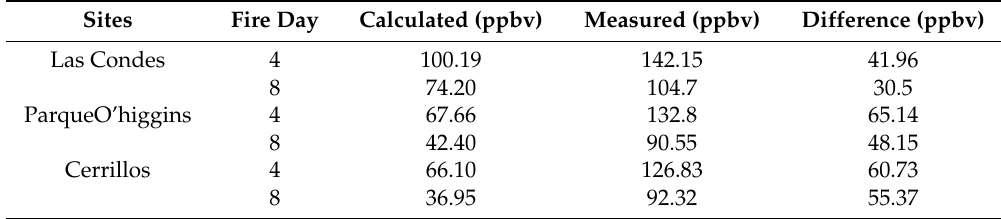
Table 2. Contribution of Melipilla’s fires to ozone maximum concentration in Santiago’s atmosphere (ground